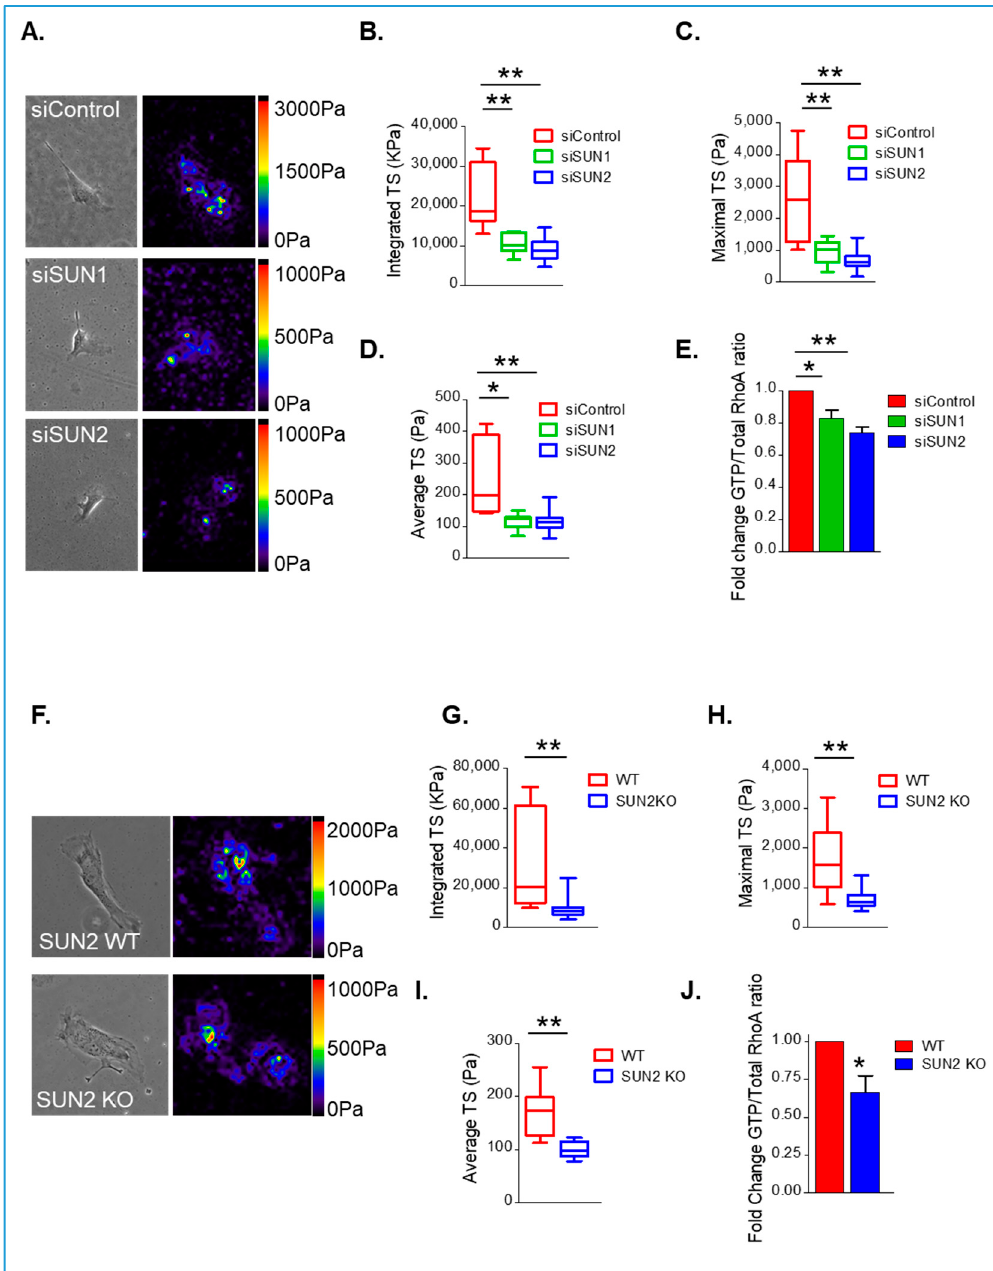
Figure 5. SUN1 and SUN2 influence actomyosin and RhoA activity. ( A ) Representative traction stress heat map of Y27632-treated control, SUN1-, and SUN2-depleted VSMCs grown on 12 kPa hydrogels. Graphs show ( B ), integrated-TS, ( C ), maximal-TS, and ( D ), cell average-TS of control ( n = 18), SUN1-depleted ( n = 15), and SUN2-depleted ( n = 17) isolated VSMCs (* p < 0.05 and ** p < 0.01). ( E ) Graph shows RhoA activity (GTP-RhoA:total RhoA ratio) in control, SUN1-, and SUN2-depleted VSMCs and represents the combined data from three independent experiments repeated in triplicate (* p < 0.05 and ** p < 0.01). ( F ) Representative traction stress heat maps of WT and SUN2 KO VSMCs grown on 12 kPa hydrogels. Graphs show ( G ), integrated-TS, ( H ), maximum-TS, and ( I ), cell average-TS of WT ( n = 10) and SUN2 KO ( n = 11) mouse VSMCs (** p < 0.01). ( J ) Graph shows RhoA activity (GTP-RhoA:total RhoA ratio) in WT and SUN2 KO mouse VSMCs. Graph represents combined data from three independent experiments repeated in triplicate (* p <